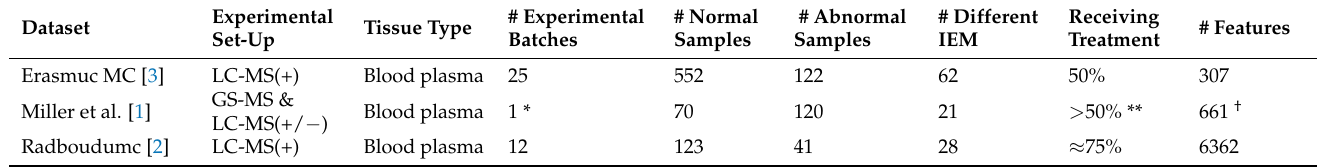
Table 1. Overview of the datasets used in this study and their characteristics. See Appendix A for more details about each dataset. * All samples are from a single experimental batch measured across three different set-ups. ** The authors only indicate that the majority of the patients received treatment. † Only annotated features for this dataset were used in this